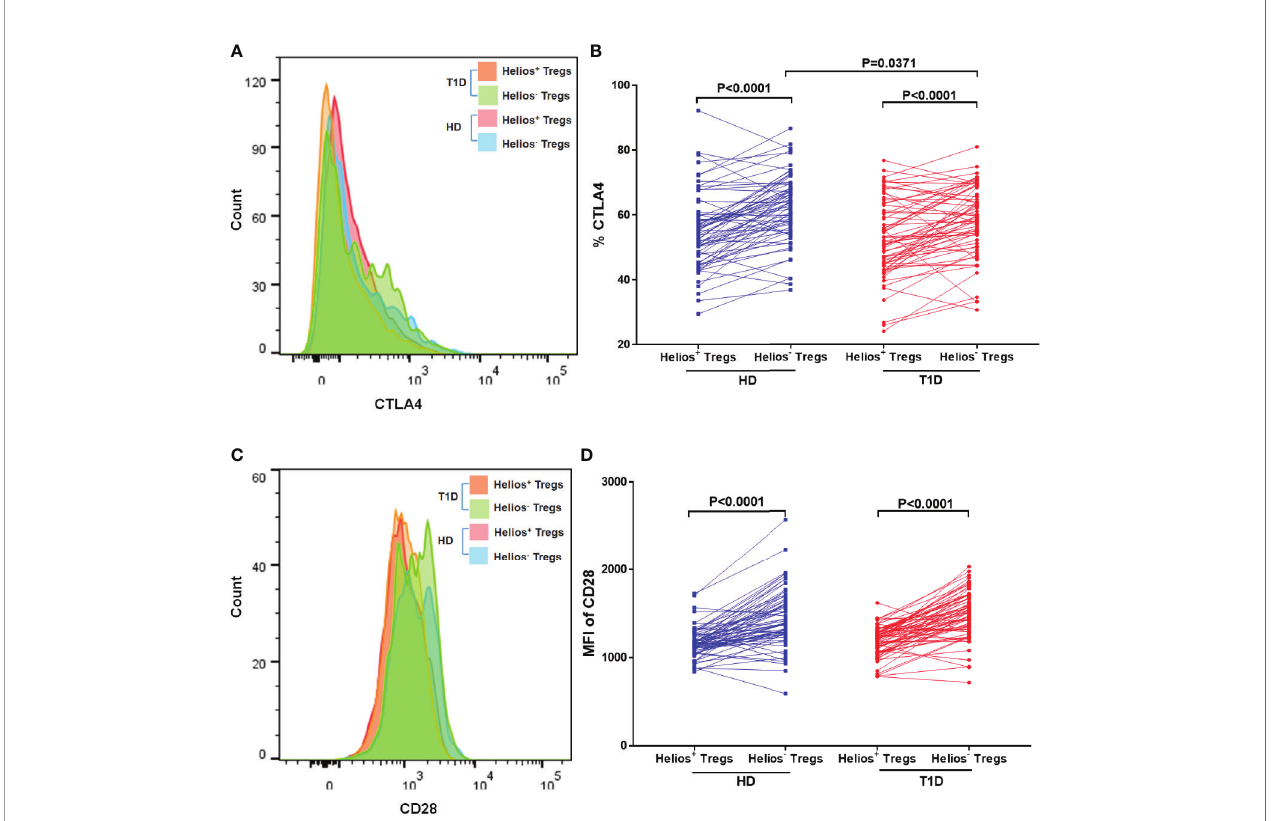
FIGURE 5 | Helios + Tregs differ in CTLA4 and CD28 expression levels with Helios − Tregs. Comparison of CTLA4 (A, B) and CD28 (C, D) expression between Helios + Tregs and Helios − Tregs from T1D individuals and healthy donors (HD). Wilcoxon rank test was used for paired statistical analysis. The results were from 68 autoantibody-positive T1D individuals and 68 age-matched autoantibody-negative healthy controls. Samples from T1D individuals and healthy controls were randomly divided to each independent experiment. One biological sample (from the same healthy donor and drawn at the same time) was performed as control for the experimental reproducibility. Comparisons between T1D and healthy controls were performed by unpaired t test with Welch ’ s correction. A p value <0.05 was considered as signi fi